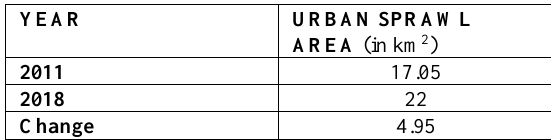
Table 2 . Urban sprawl in square kilometer for Aligarh City